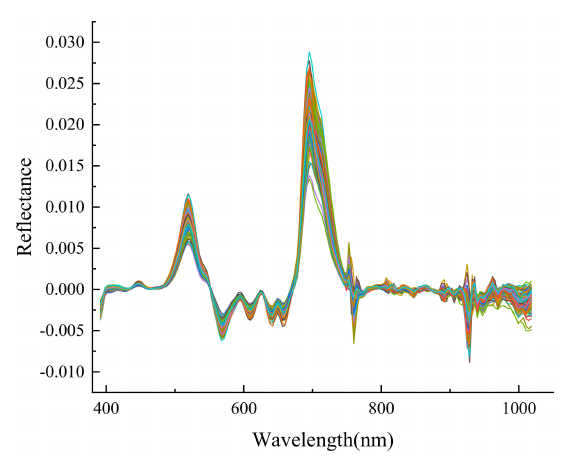
Figure 8. 1st derivative